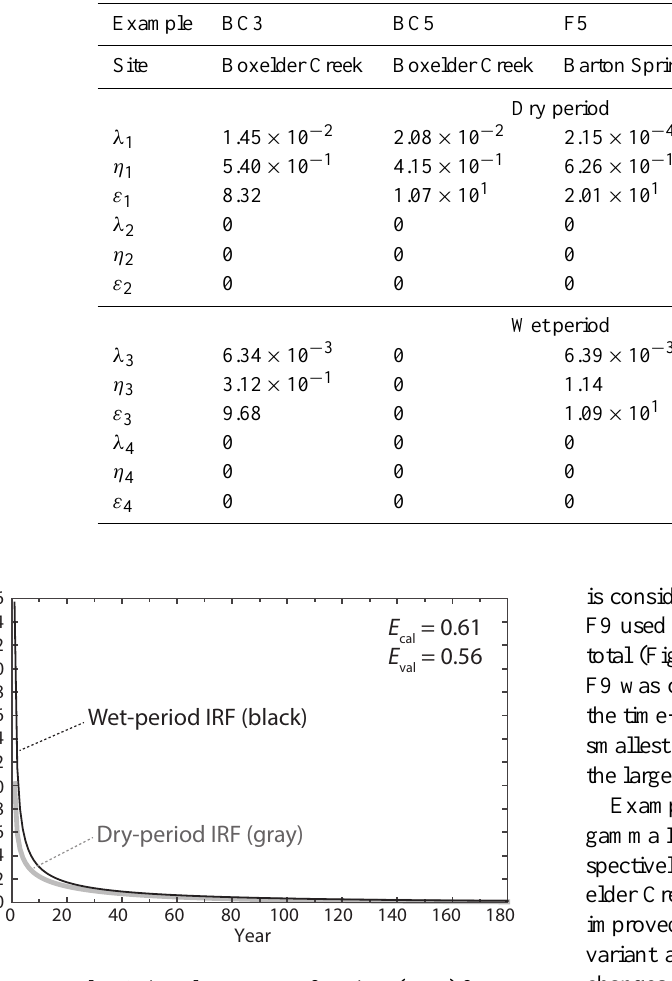
Figure 5. Example B3: impulse-response functions (IRFs) for Box- elder Creek using single-gamma